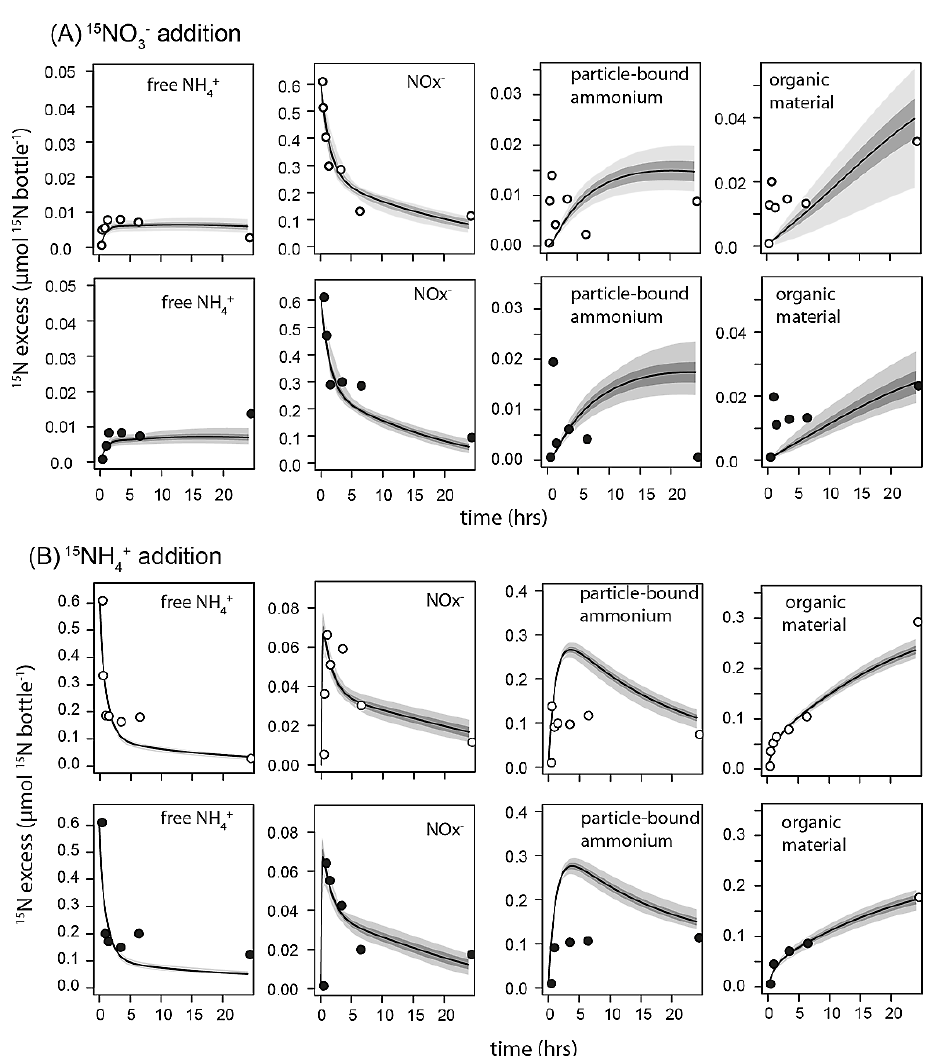
Fig. 4. Measured pools of 15 N for 15 N-nitrate additions (A) and 15 N-ammonium additions (B) in dark (filled circles) and light (open circles). Solid lines and shading indicate model fits. Dark shaded areas represent one standard deviation; light shading indicates minimum and maximum values. Note different scales of